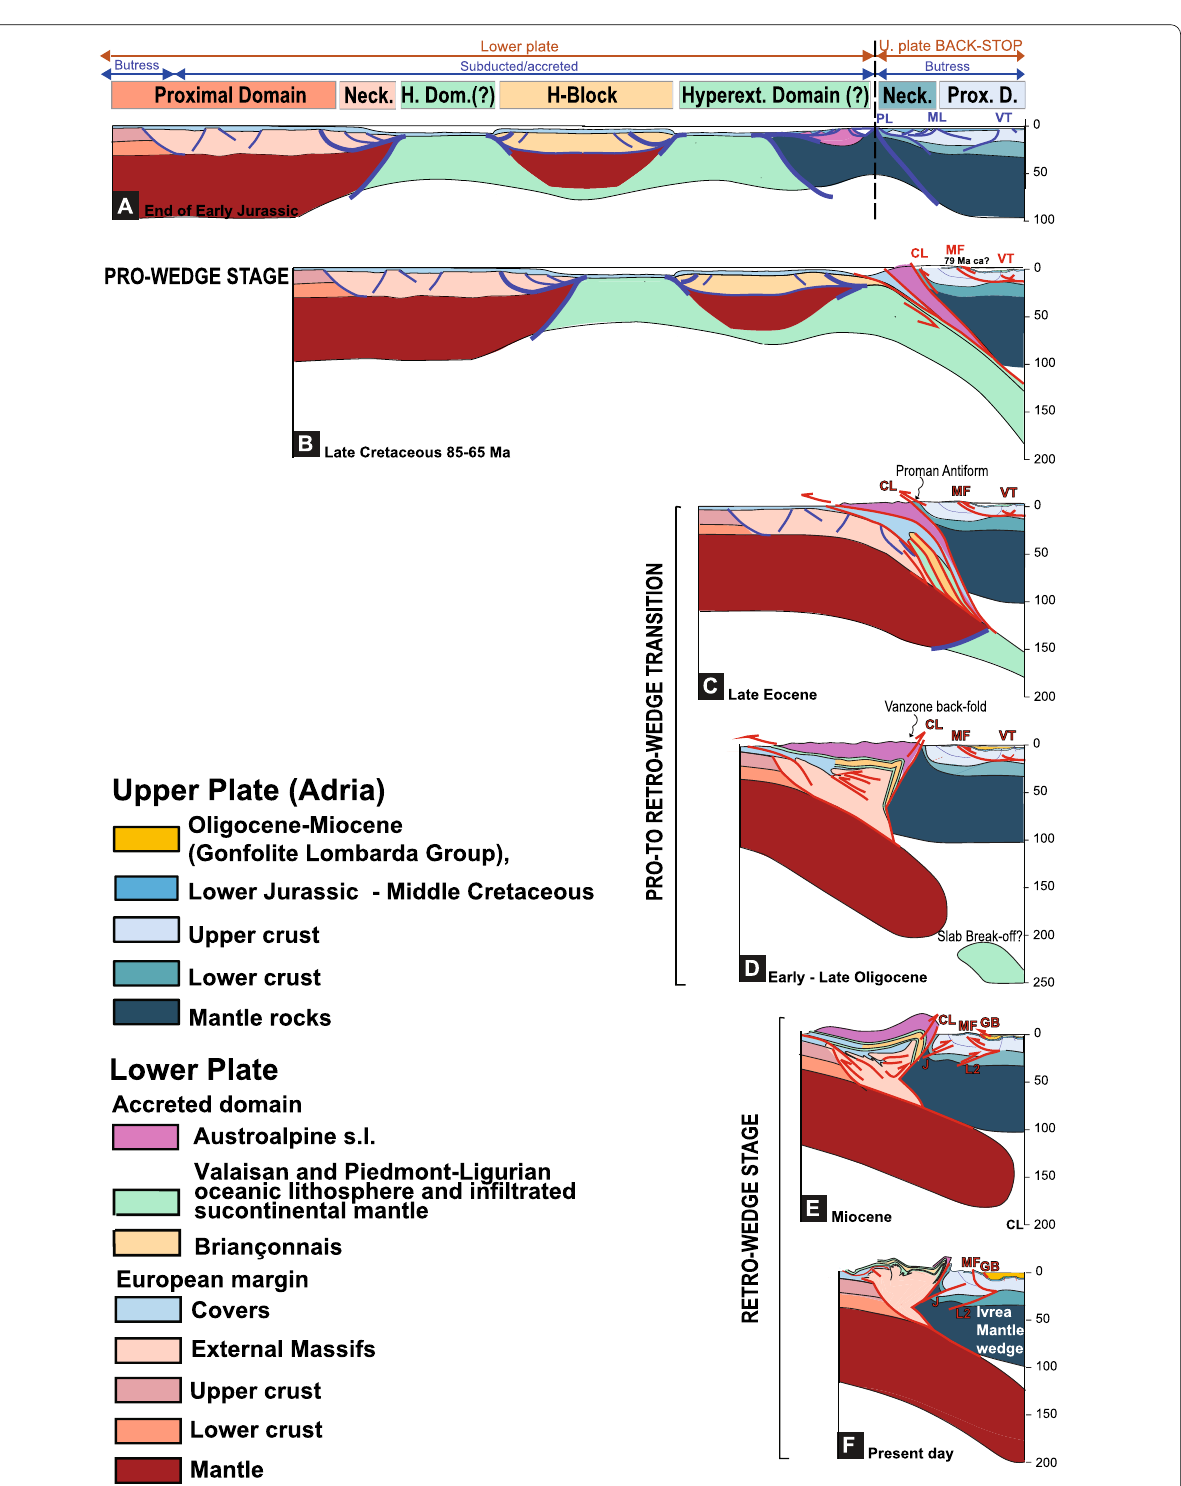
Fig. 11 Key steps in the evolution of the Alps with focus on the Southern Alps and on the inheritance of rift-related extensional domains (sensu Mohn et al., 2010) during collision. See text for a detailed explanation (redrawn after Butler, 2013; Dezes et al., 2004; Handy & Stünitz, 2002; Mohn et al., 2014). Fault Codes: AT: Arosio thrust; CL: Canavese Line; GB: Gonfolite backthrust; J and L2 are deep-seated shear zones discussed in this study; MF: Marzio Fault; ML: Maggiore Line; PL: Pogallo Line; VT: Villafortuna-Trecate